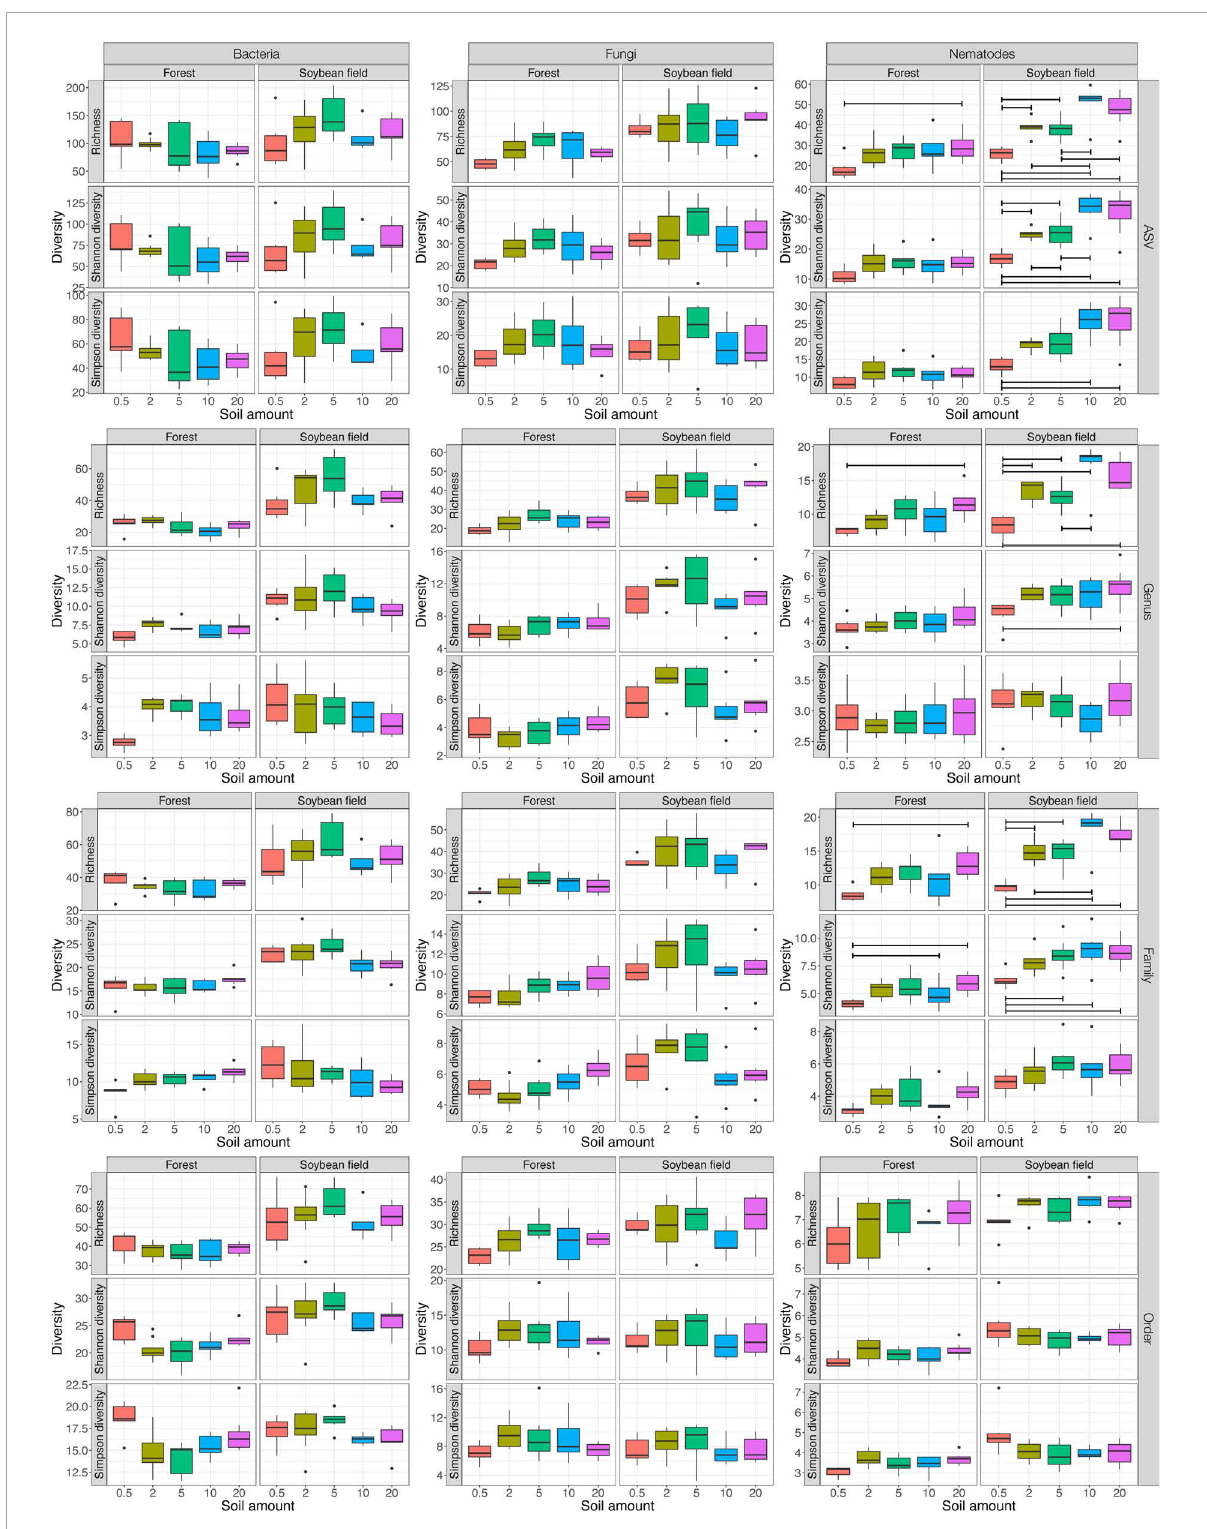
FIGURE1 Effects of soil amount in DNA extraction on α -diversity estimates. For each of the bacterial 16S rRNA, fungal ITS, and nematode 18S rRNA datasets, taxonomic richness, Shannon diversity, and Simpson diversity are shown with boxplots at the ASV, genus, family, and order levels, respectively. See Table 1 for ANOVA results. For each ecosystem type (forest or soybean field), statistically significant difference inferred by Tukey’s HSD test is indicated by horizontal bars within the panels ( P < 0.05).